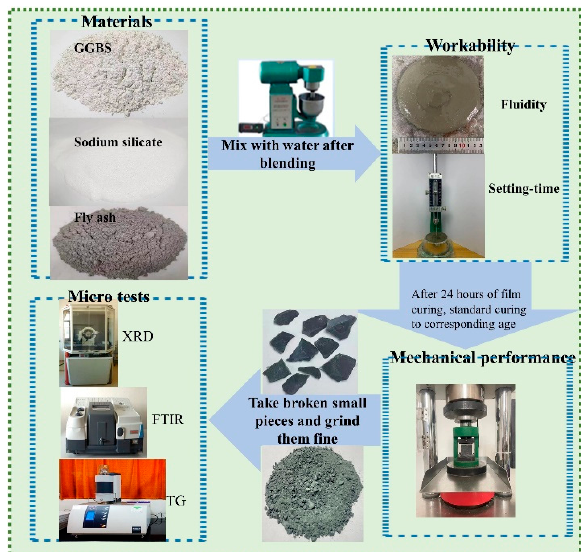
Figure 3. Flow chart for experiments.